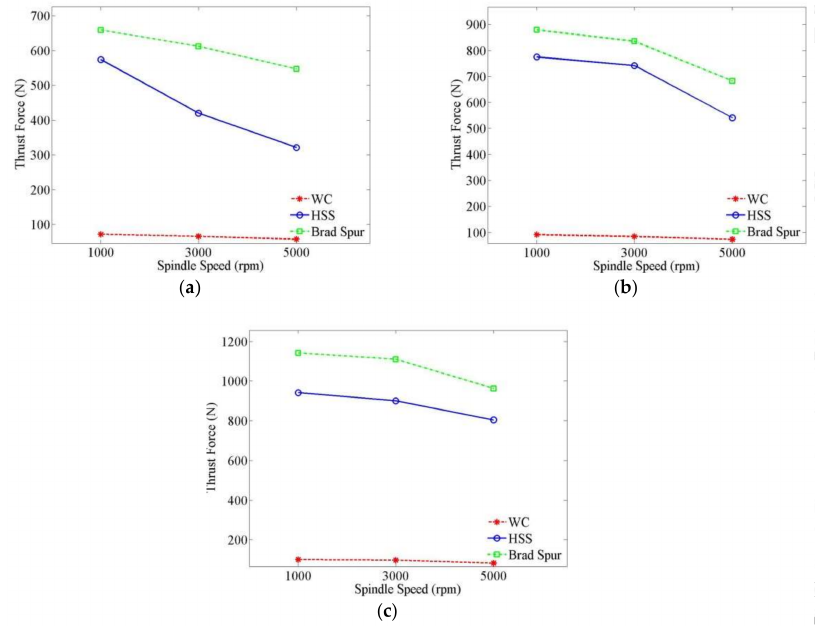
Figure 7. Variation of drilling parameters on thrust force: ( a ) 0.05 mm/rev; ( b ) 0.10 mm/rev; ( c ) 0.15